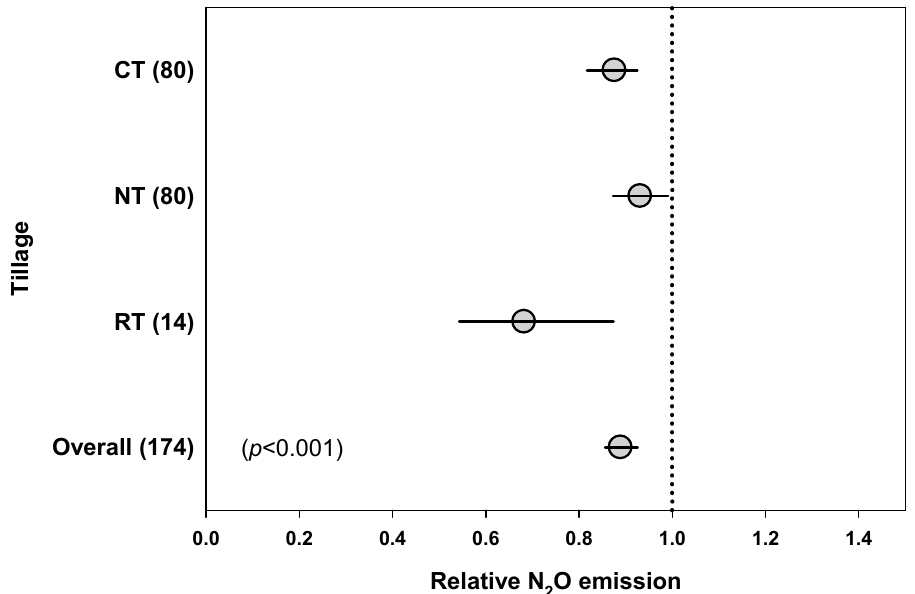
Figure 4. The effect crop residue removal on N 2 O emissions as affected by soil tillage. N 2 O emissions from control treatments with crop residues = 1. Mean effect size (circle) and 95% confidence intervals (CIs, error bars) are shown. CT = conventional tillage, RT = reduced tillage, NT = no or zero tillage. The number of observations is given in parentheses.